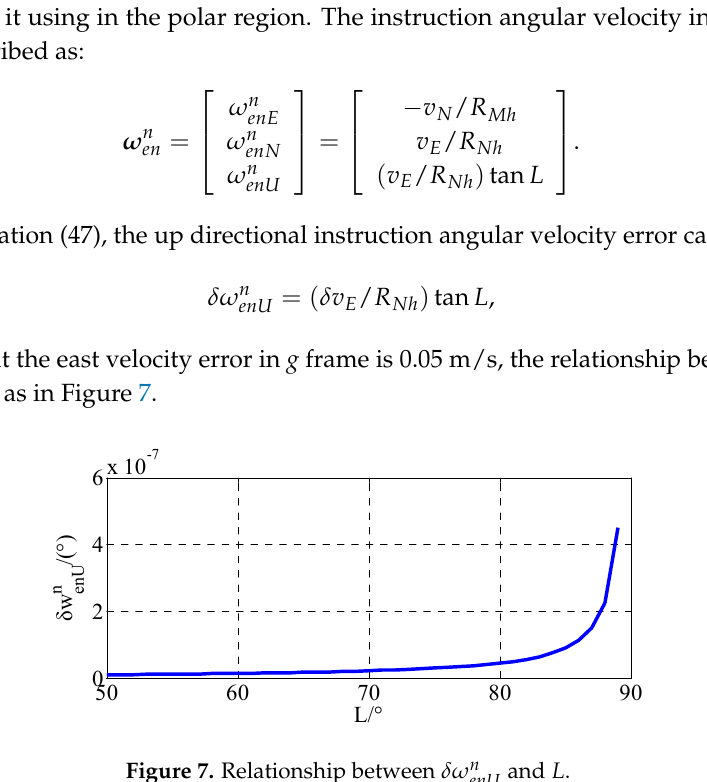
Figure 7. Relationship between n